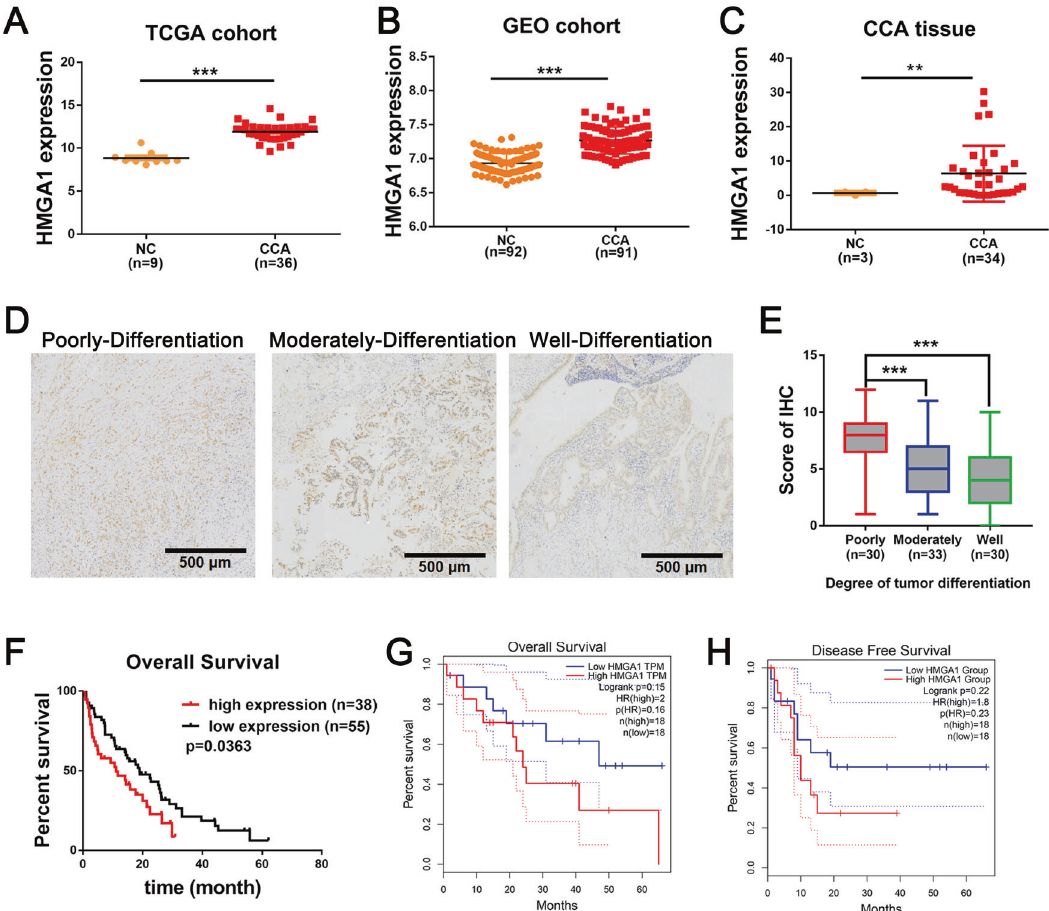
Fig. 1 HMGA1 is frequently upregulated in CAAs and is correlated with a poor prognosis. A – C Expression analysis of HMGA1 in TCGA CAA, GSE76297 and Qilu hospital cohorts. D Representative images of immunohistochemical (IHC) staining of HMGA1 in our tissue microarray (containing 93 samples of CCA tissues collected from Qilu Hospital, Shandong University). E Statistical analysis of HMGA1 expression from IHC staining of our tissue microarray. High and low expression indicate the fi nal score of each sample determined by two pathologists based on the intensity and extent of staining across the tissue microarray section. CCA patients were dichotomized into low (Score < 7) and high (Score ≧ 7) HMGA1 protein expression groups based on the IHC staining score. The high and low expression groups were separated based on the best cutoff. F Kaplan – Meier analysis of the correlation between HMGA1 expression and clinical prognosis based on data from our tissue microarray. G , H Kaplan – Meier analysis of the correlation between HMGA1 expression and the clinical prognosis